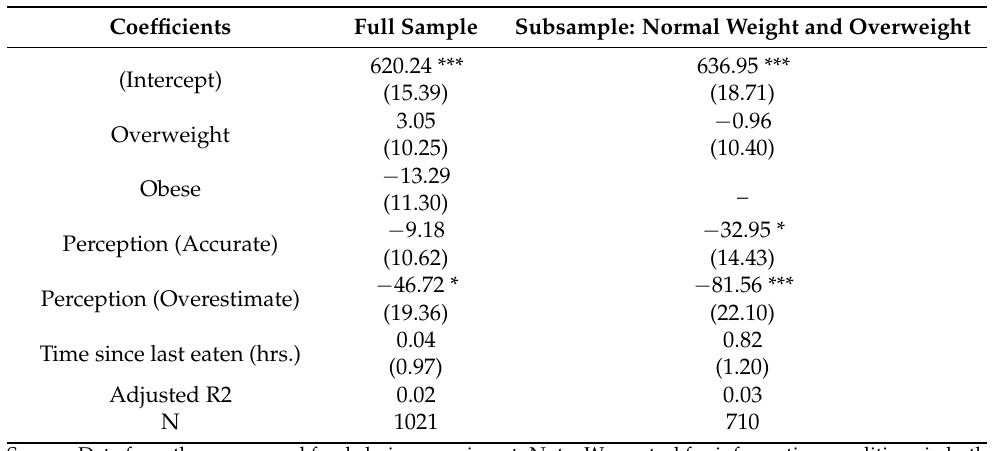
Table A1. Regression results including variable capturing the amount of time since the individual had last